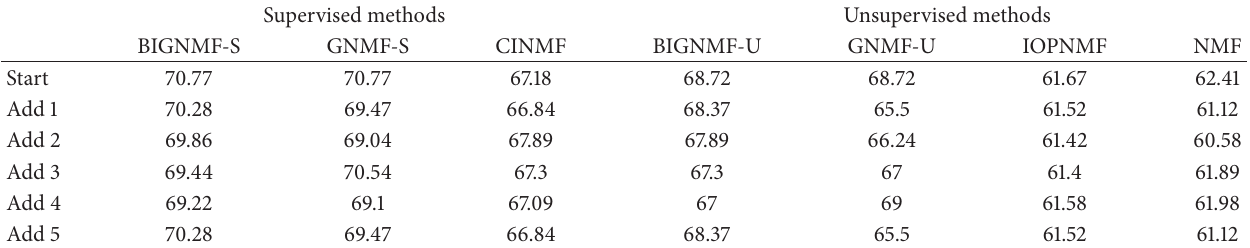
Table 1: The recognition rates (%) for the FERET database during adding 5 batches of images belonging to one class. Supervised methods